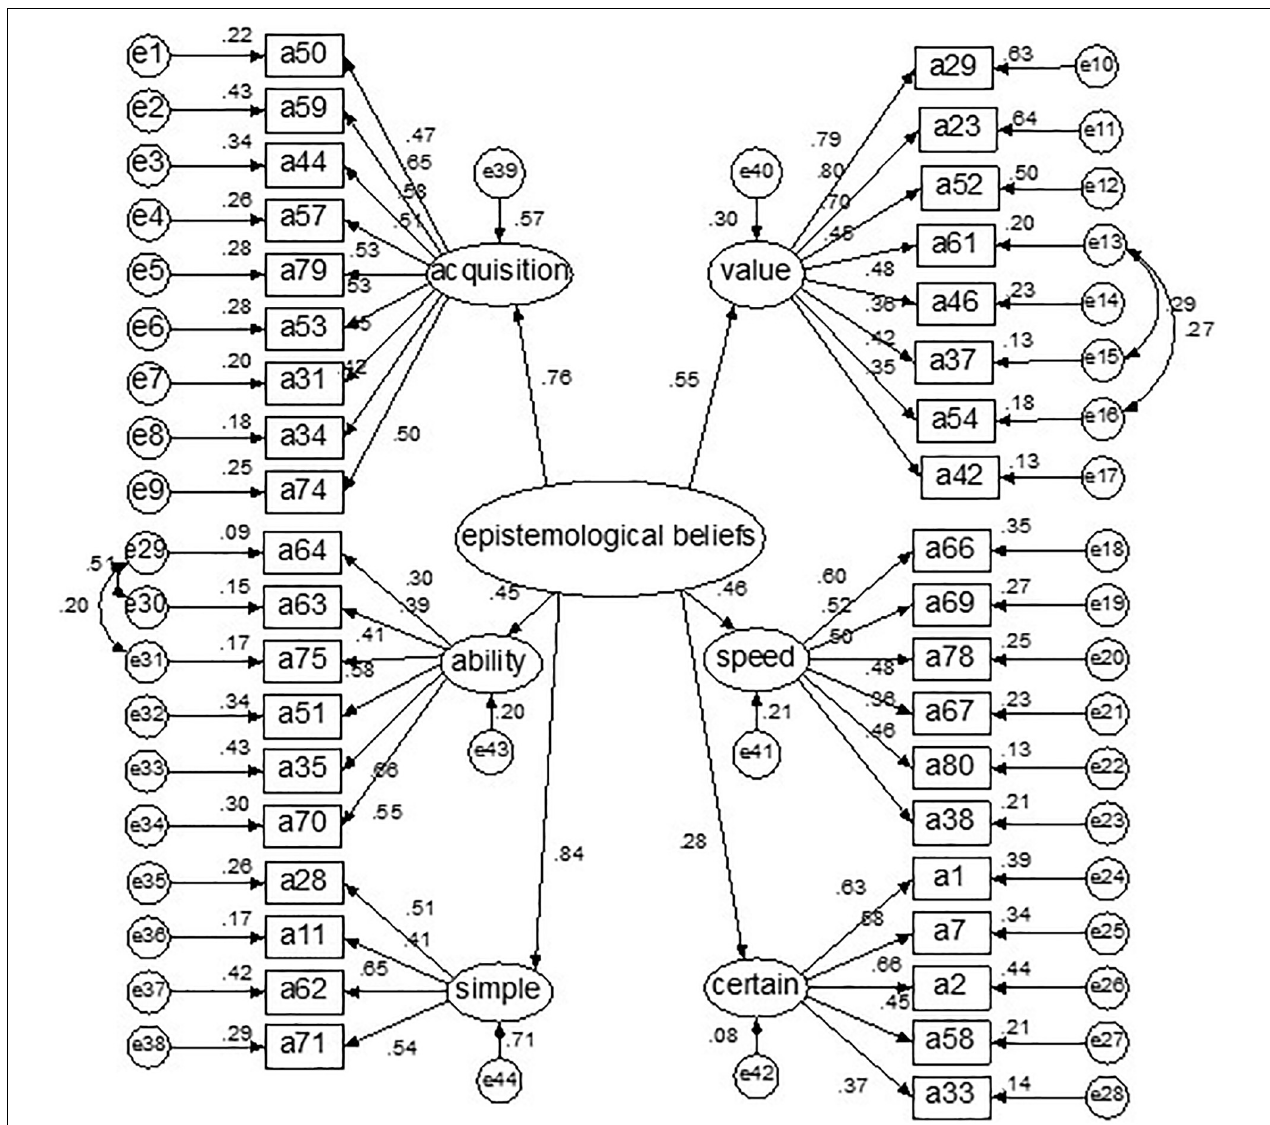
FIGURE 1 | CFA results of Chinese college students’ epistemological beliefs